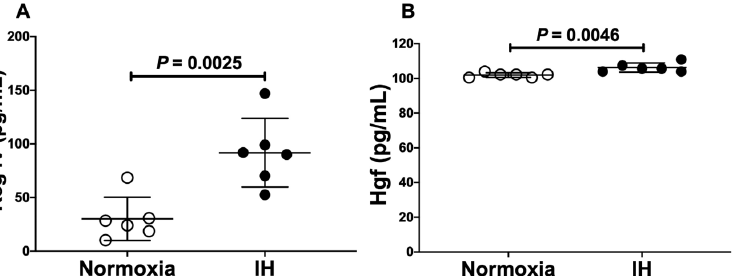
Figure 3. Concentrations of ( A ) Reg IV and ( B ) Hgf in a mouse P19.CL6 cardiomyocyte culture medium. P19.CL6 cardiomyocytes were treated by normoxia or IH condition for 24 h. The concentrations of Reg IV and Hgf were measured by ELISA. Open and closed circles indicate values of culture medium of cells exposed to normoxia and IH, respectively. Data are expressed as mean ± SD for each group. The statistical analyses were performed using Student’s t -test.